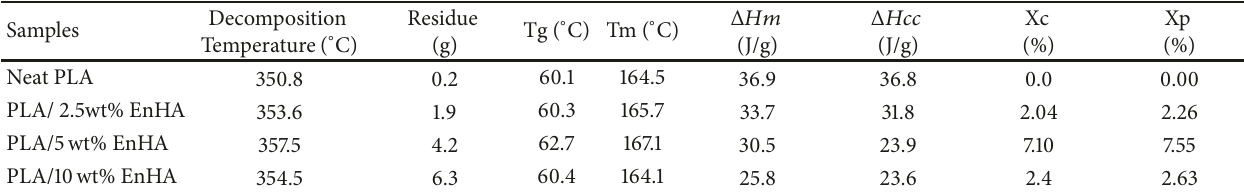
Figure 4: High magnification SEM micrographs of (a) neat PLA, (b) PLA/ 5wt% EnHA, (c) PLA/10wt% EnHA, and (d) EDS spectrum of PLA/10wt% EnHA. Table 1: TGA results for neat PLA and PLA/EnHA electrospun